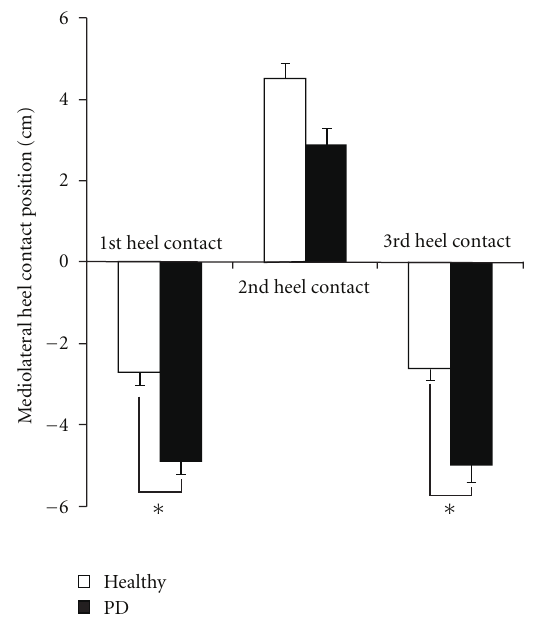
Figure 4: Mediolateral heel contact positions. Data columns indi- cate the mean, and error bars indicate standard errors of the mean. Asterisks indicate a significant di ff erence between the groups ( P < 0 .